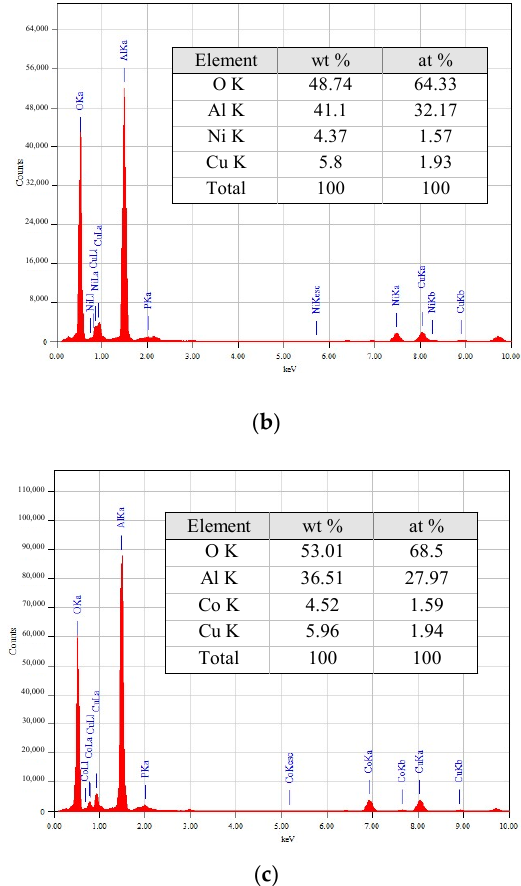
Figure 5. TEM-EDX elemental analyses of the ( a ) 5Ni5CoAl ( b ) 5Ni5CuAl and ( c ) 5Co5CuAl catalyst samples.